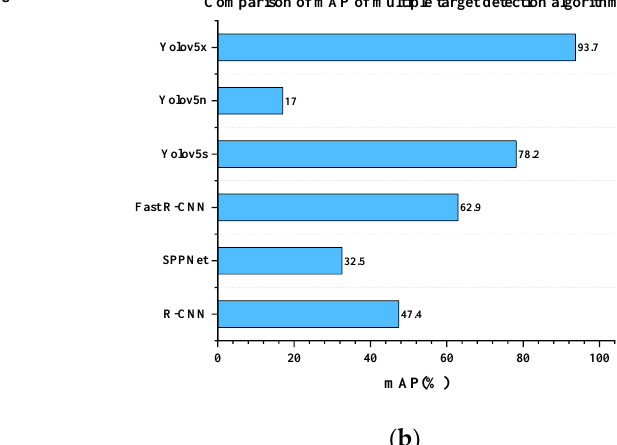
Table 4. Test time of multiple target-detection models.